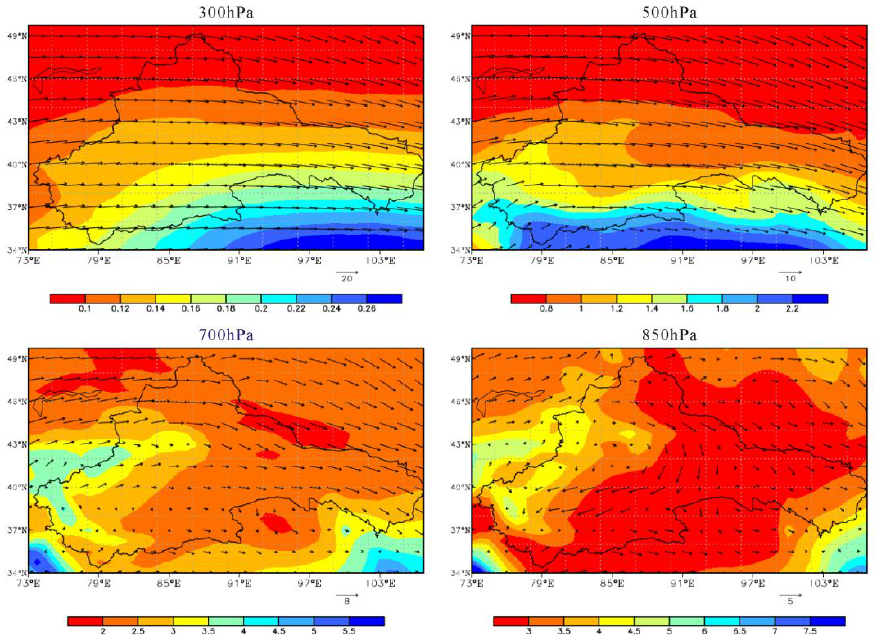
Figure 9. The long-term mean spatial distribution of the wind field at different atmospheric levels during the period 1980–2018.